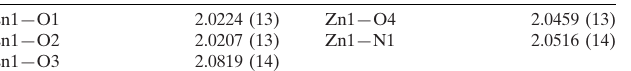
Selected bond lengths (A˚ ).